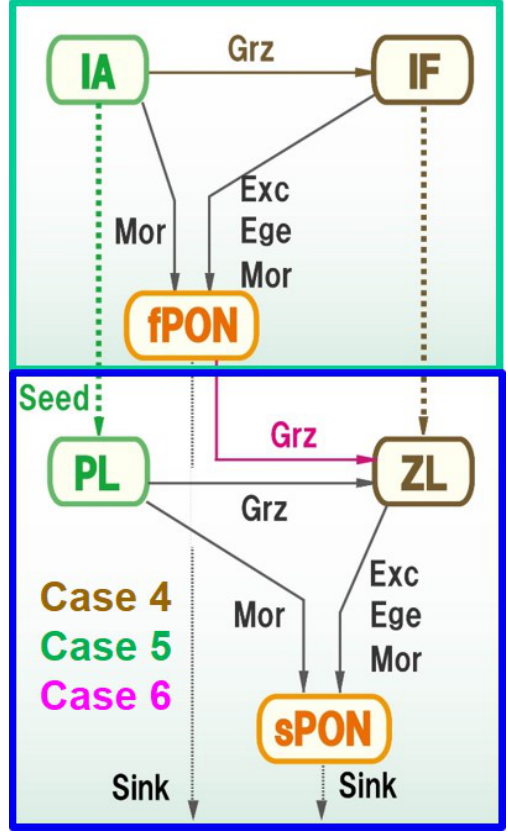
Figure 13. Schematic image of sensitivity experiments. In Case 4, the grazing pressure of ice-related fauna (IF) on ice algae (IA) and the transition from IF to mesozooplankton (ZL) after sea ice melting were calculated for the seeding. In Case 5, a part of IA was treated as large phytoplankton (PL) after sea ice melting. In Case 6, the ZL grazing on fast-sinking particulate organic nitrogen (fPON) was calculated in the water column, and the formulation of slow-sinking one (sPON) was not